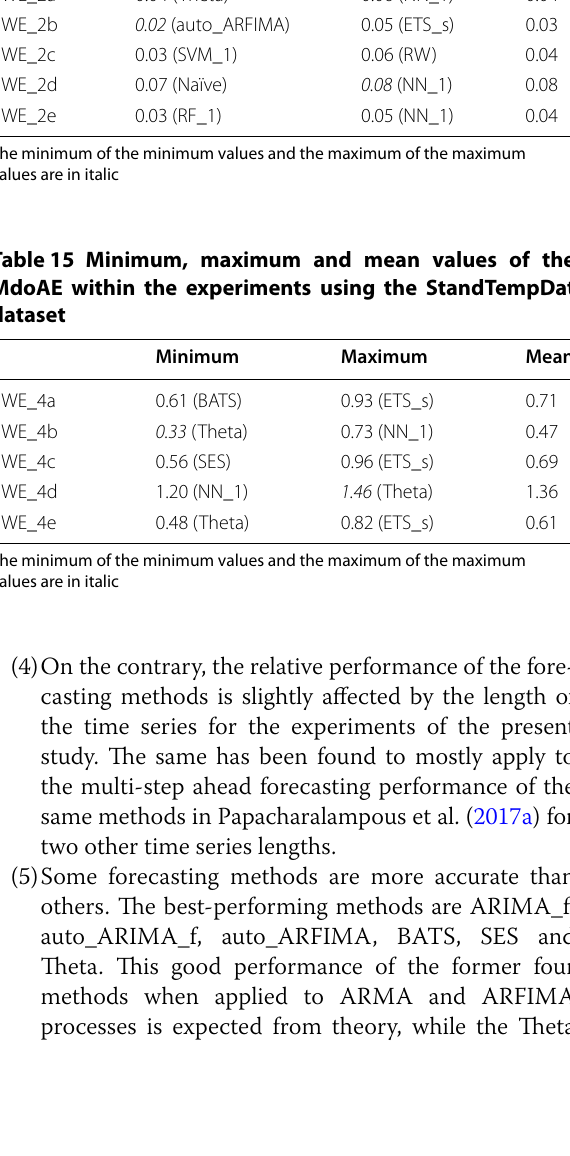
Table 14 Minimum, maximum and mean values of the MdoAPE within the experiments using the TempDat data- set